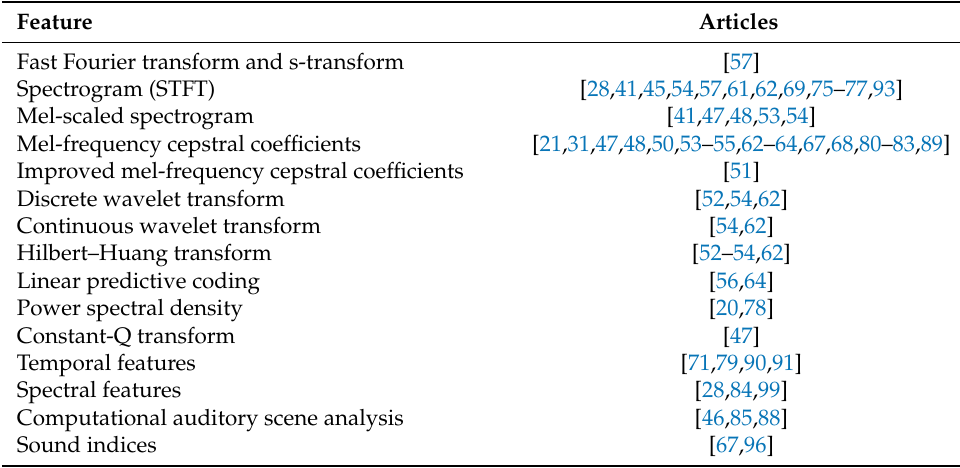
Table 6. Feature extraction methods